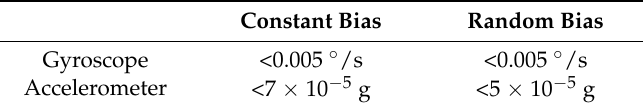
Table 4. The main parameters of the